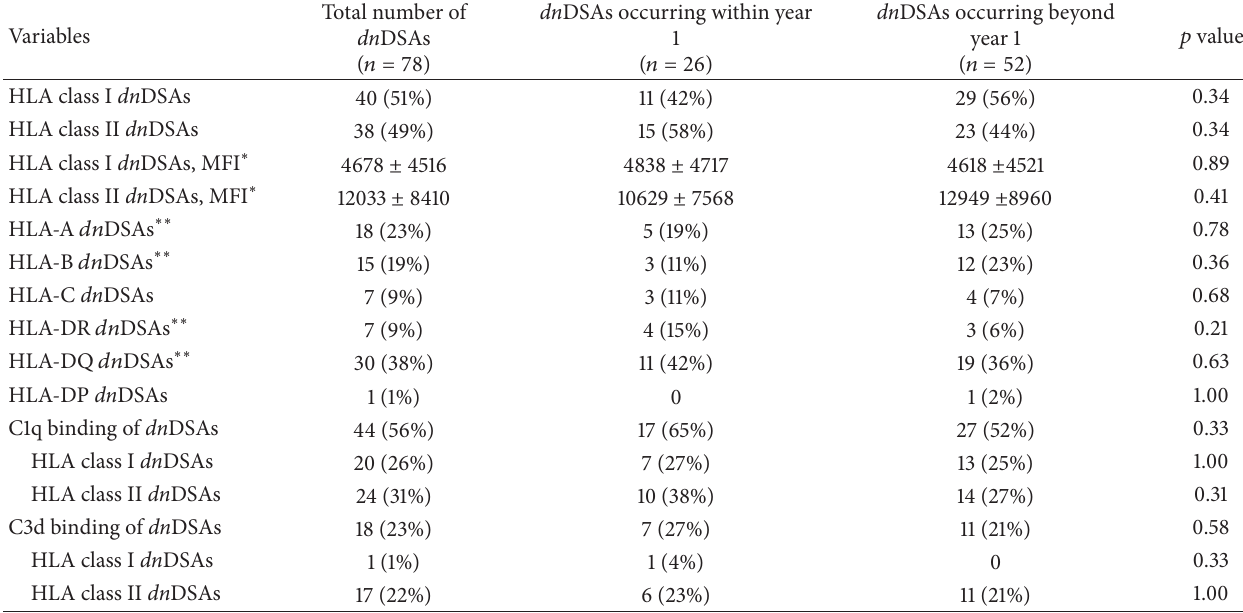
Table 3: Characteristics of 78 de novo donor specific HLA antibodies ( dn DSAs) detected in 39 DSA positive kidney recipients. Variables